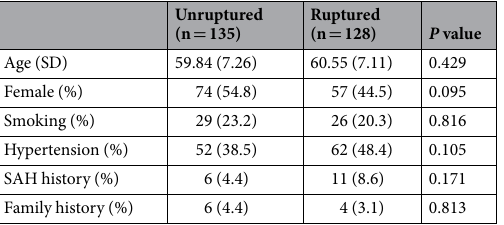
Table 1. Demographic information and clinical risk factors for patients with ruptured and unruptured small intracranial aneurysms.